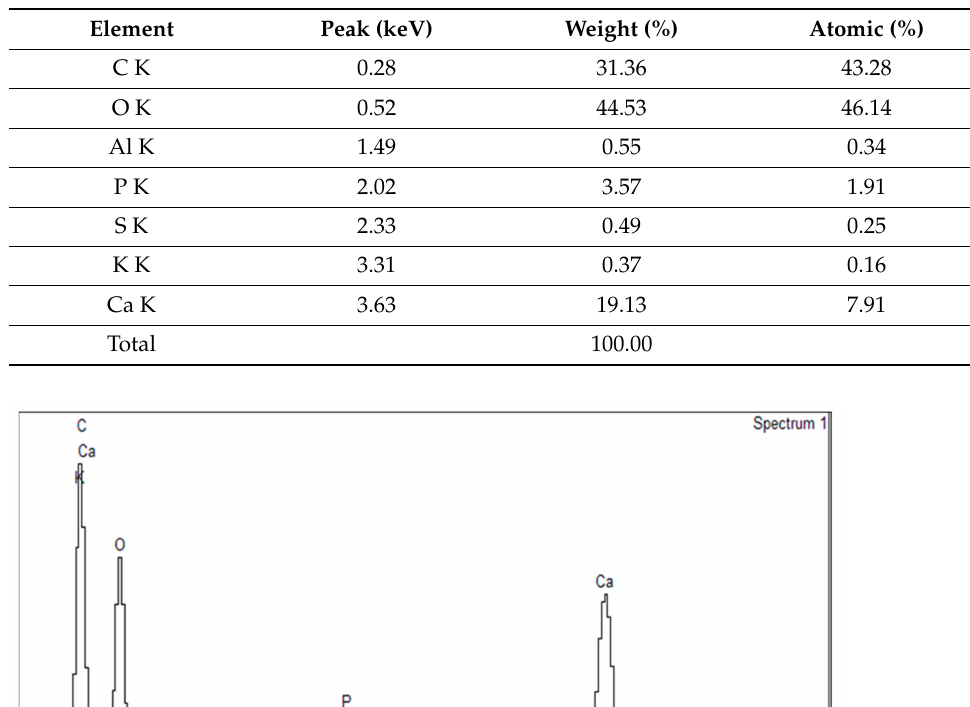
Figure 5. Electron image for EDX analysis. Table 2. EDX analysis element content.